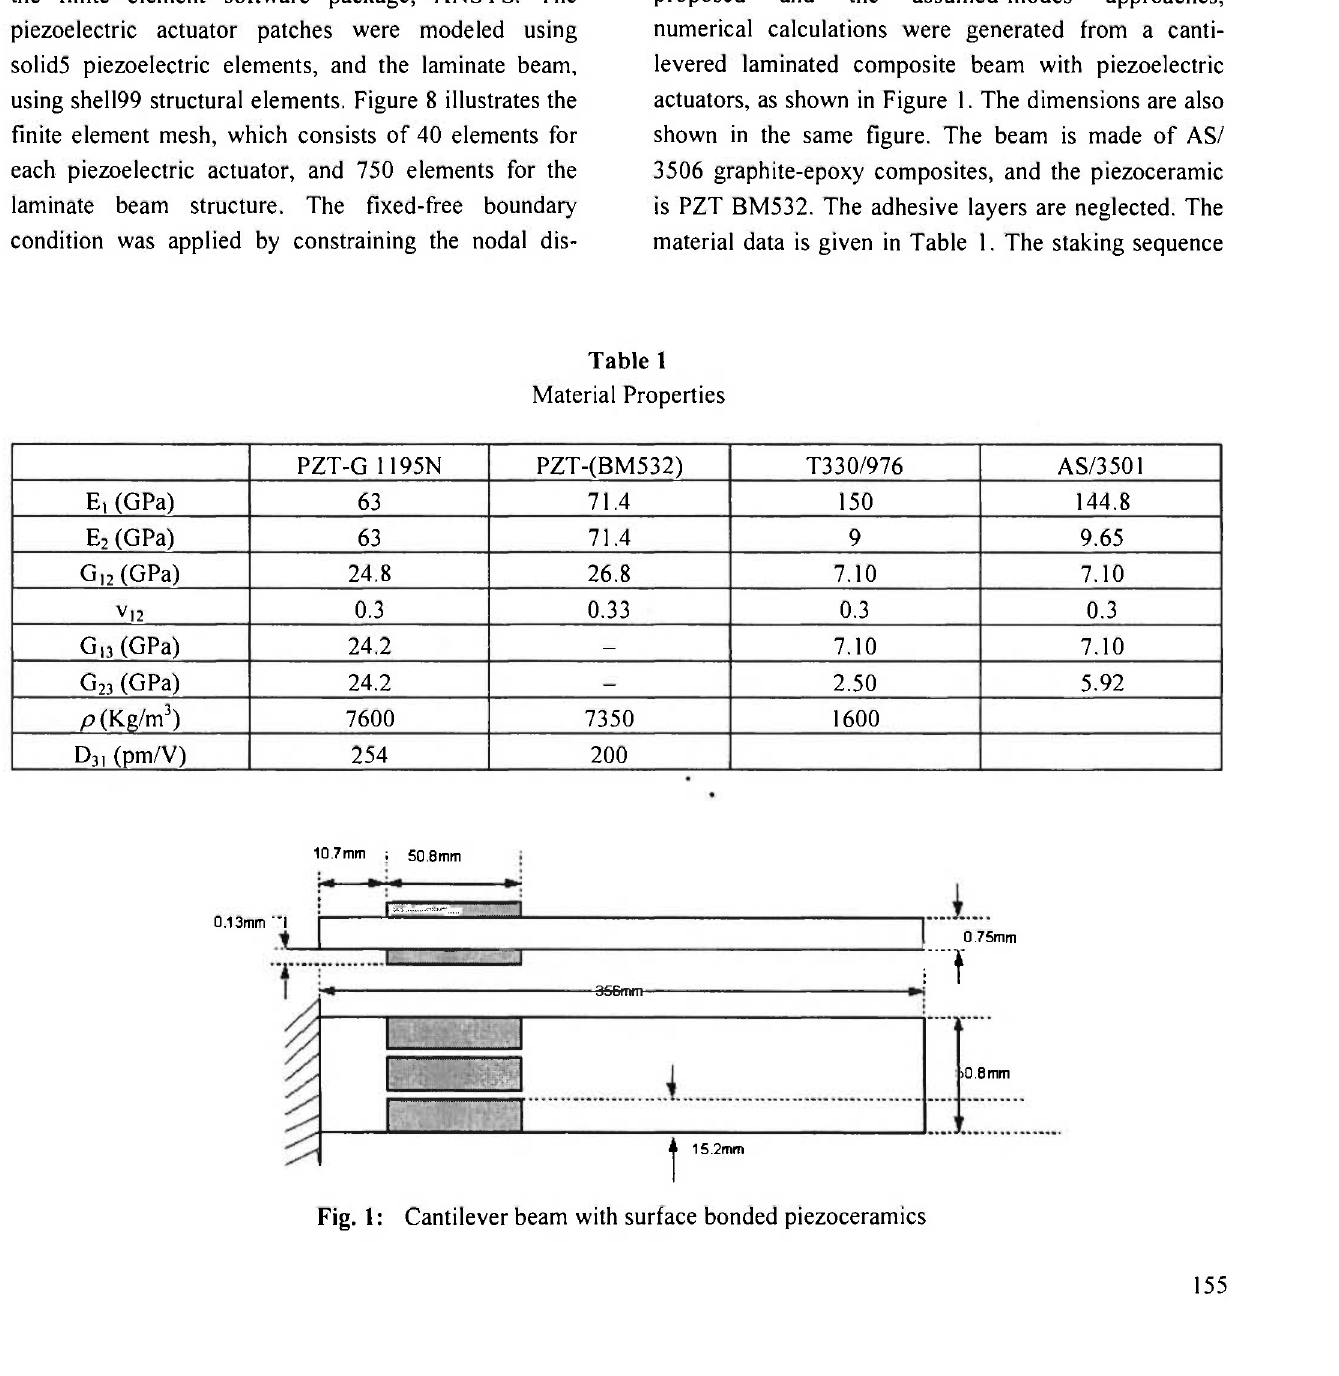
Fig. 1: Cantilever beam with surface bonded